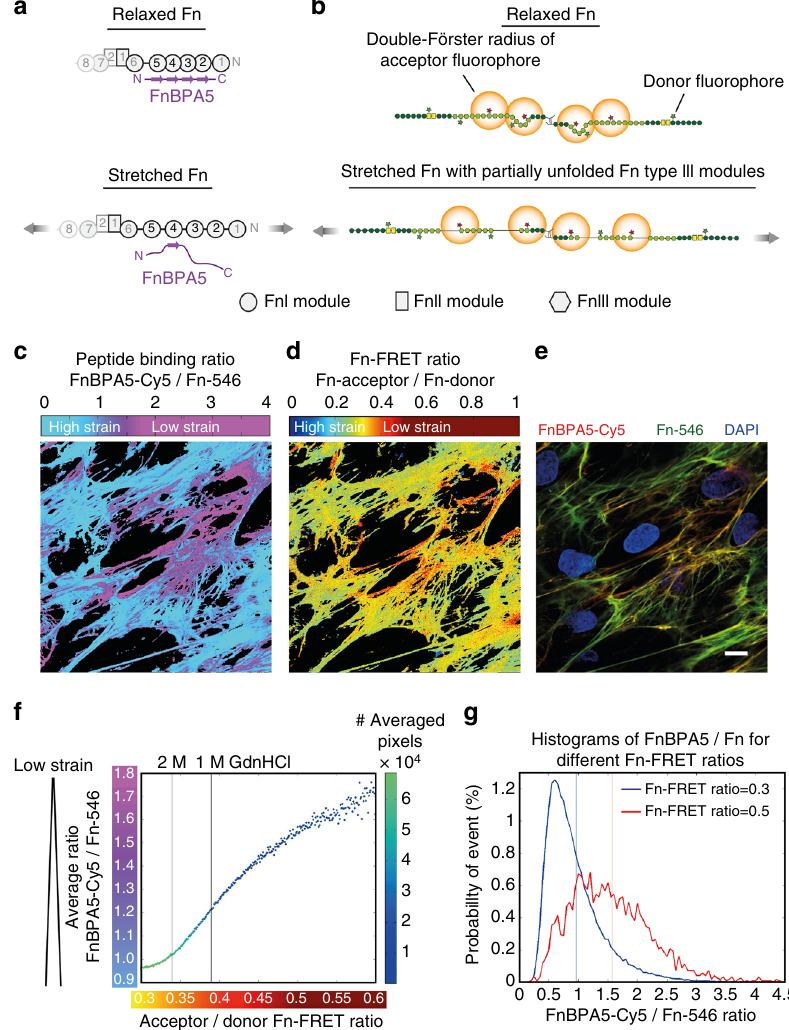
Fig. 3 Comparison of FnBPA5 binding to a fi broblast-grown native Fn matrix using a Fn-FRET probe. a Schematic of strain-sensitive binding of FnBPA5 to N-terminal FnI domains of Fn. b Schematic of Fn-FRET probe with acceptor fl uorophores at speci fi ed domains and donor fl uorophores at random locations, exhibiting a lower energy transfer in stretched ECM fi bers compared to relaxed ones. c FnBPA5-Cy5 was normalized with directly excited Fn-546, showing in the false color ratiometric image high FnBPA5 binding in violet areas. d False color ratiometric image of Fn-Acceptor 546/Fn-Donor 488 (FRET ratio). Red colors represent higher FRET ratios representing more relaxed Fn conformations, whereas blue colors show lower FRET ratios corresponding to regions with more stretched Fn. e Merged fl uorescence image of FnBPA5-Cy5 (red), Fn-546 (green), and DAPI (blue) from the same fi eld of view as in c and d . Scale bar, 10 μ m. f Quantitative analysis of average FnBPA5 binding vs. Fn-FRET ratios for all images ( n > 10) of an experiment shows an increase in FnBPA5 binding for higher FRET ratios. Number of pixels used for averaging is given in the color code. g Histograms of the FnBPA5-Cy5/Fn-546 ratios for two selected Fn-FRET ratios (0.3 and 0.5). Vertical lines represent the arithmetic means of the distributions. Shift of distribution of FnBPA5/Fn for the FRET value of 0.5 (red) indicates a higher overall binding compared to distribution for FRET value of 0.3 (blue). Please note that the FnBPA5-Cy5/Fn-546 ratios are intensity ratios and do not give the ratios of